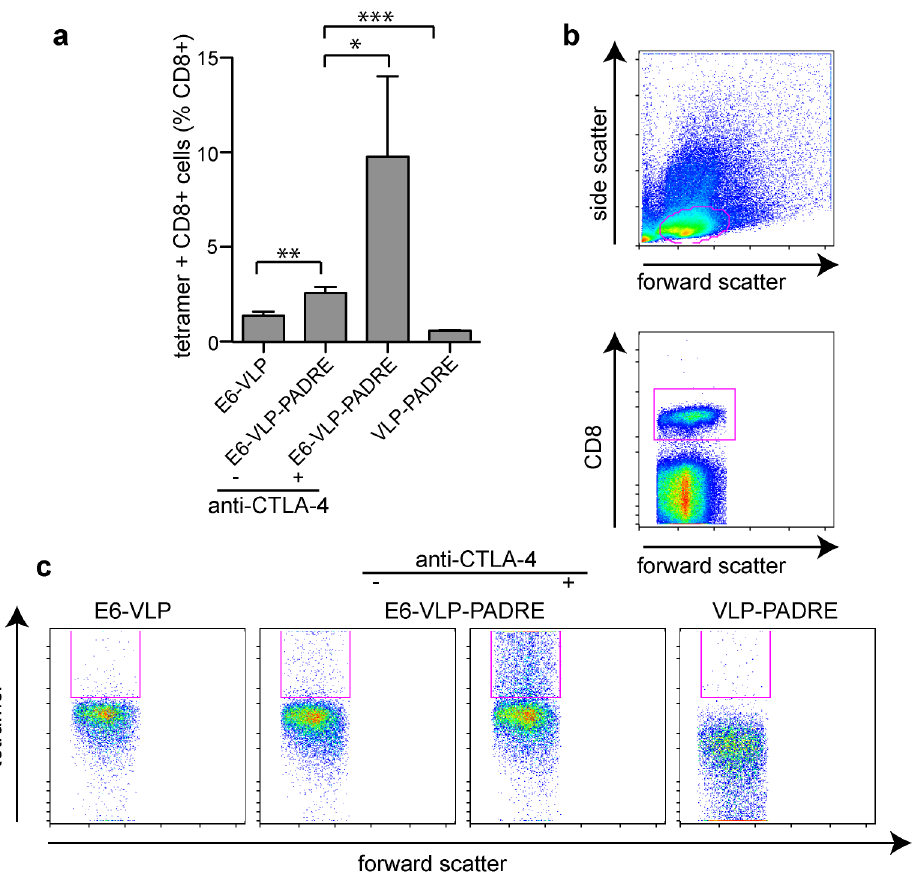
Figure 6. Analysis of the E6-specific CD8 + T cell response to immunization with CTLA-4 treatment. (a) Peripheral blood from mice immunized with E6-RHDV-VLP, E6-RHDV-VLP-PADRE, untreated or treated with anti-CTLA-4 antibody, or RHDV-VLP-PADRE (n=8/group) was analysed for E6-specific CD8 + cells. (b) Lymphocytes were gated based on forward and side scatter and of those events, CD8 + T cells were analysed. (c) A representative sample of tetramer staining on CD8 + lymphocytes is shown for each of the vaccination